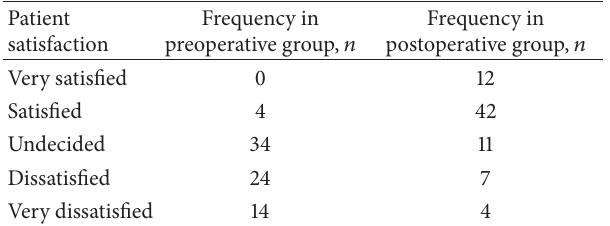
Table 1: Patient satisfaction with cosmesis before and after surgery.